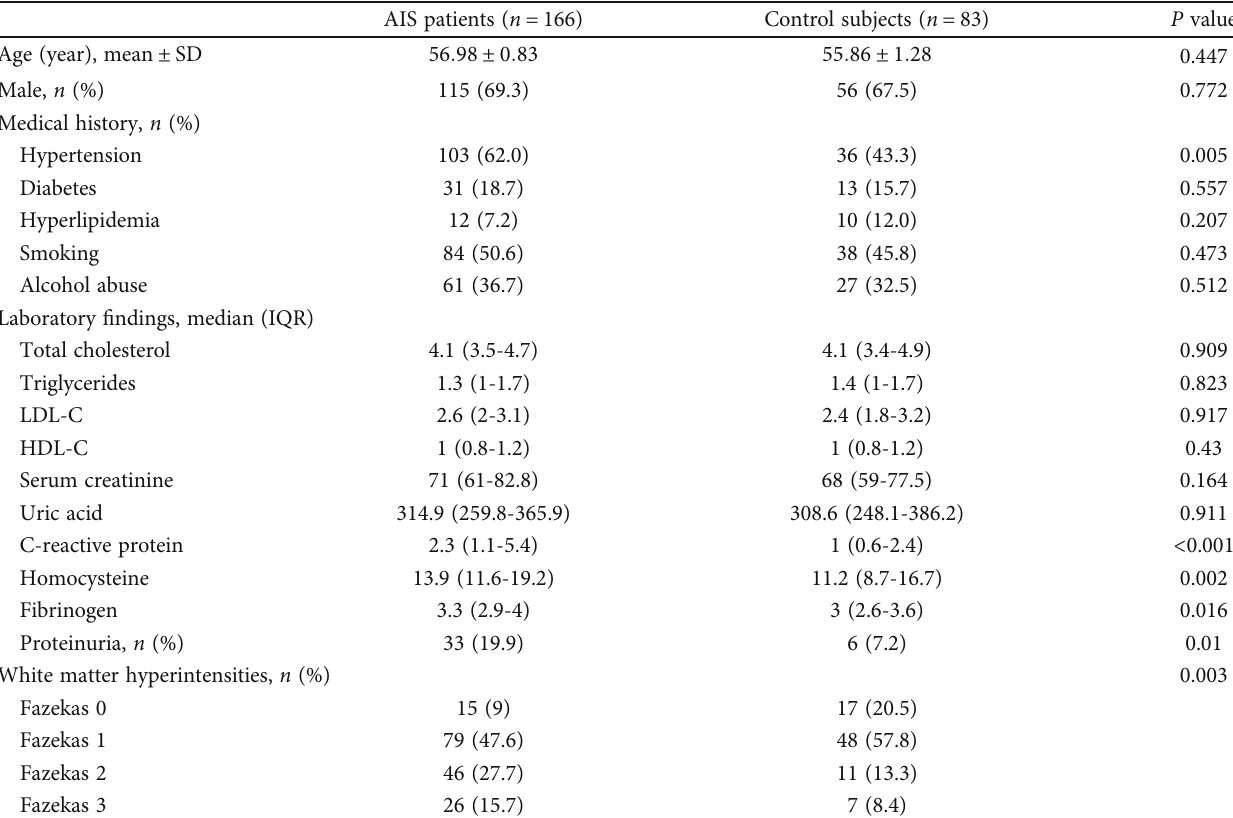
Table 2: Baseline characteristics of AIS patients and control